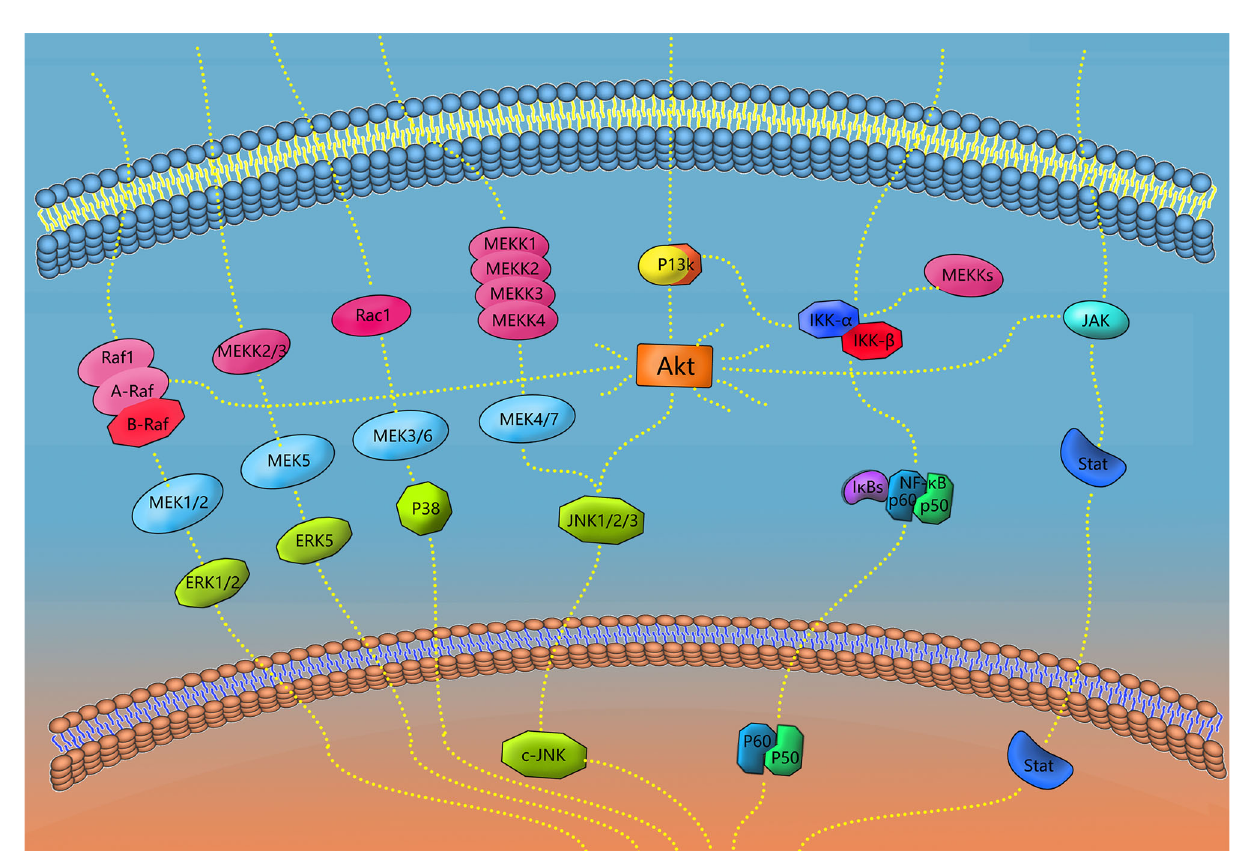
FIGURE 3 | Signaling pathways of polarization and functional expression of periodontal macrophages. In this review, four types of signaling pathways in periodontal macrophages were selected, including MAPK, NF- k B, JAK/STAT, and AKT. When the receptor on the cell membrane is stimulated, the corresponding signaling pathway plays a role, and fi nally transduces the signal to DNA, transcription and translation of the corresponding effector molecules. A diagram of some links of the signaling pathway mentioned in this paper is shown in the fi